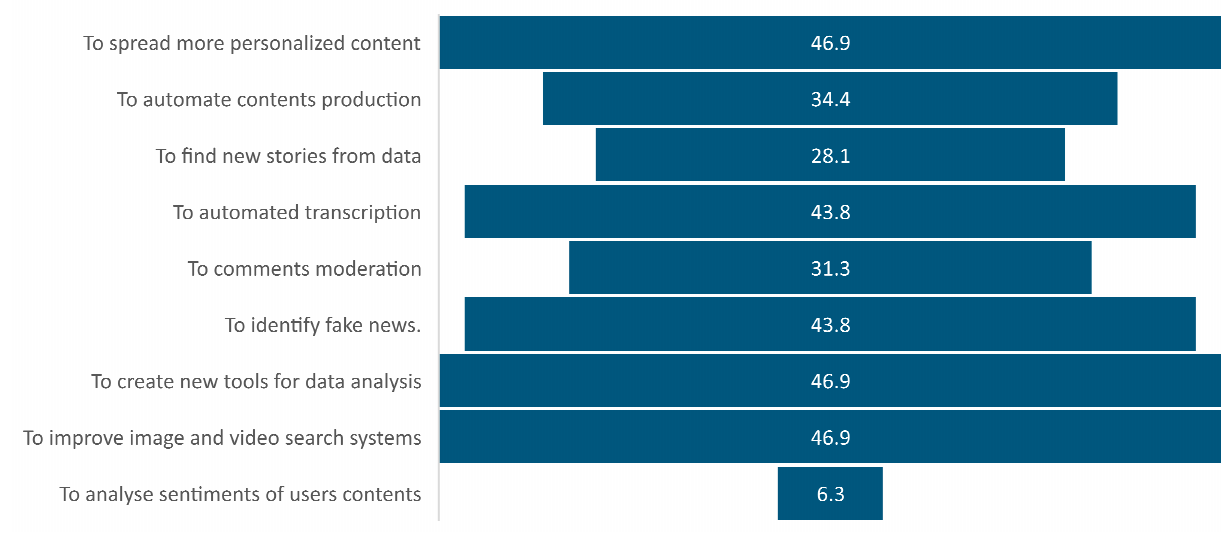
Figure 7. How IA can help journalism in the